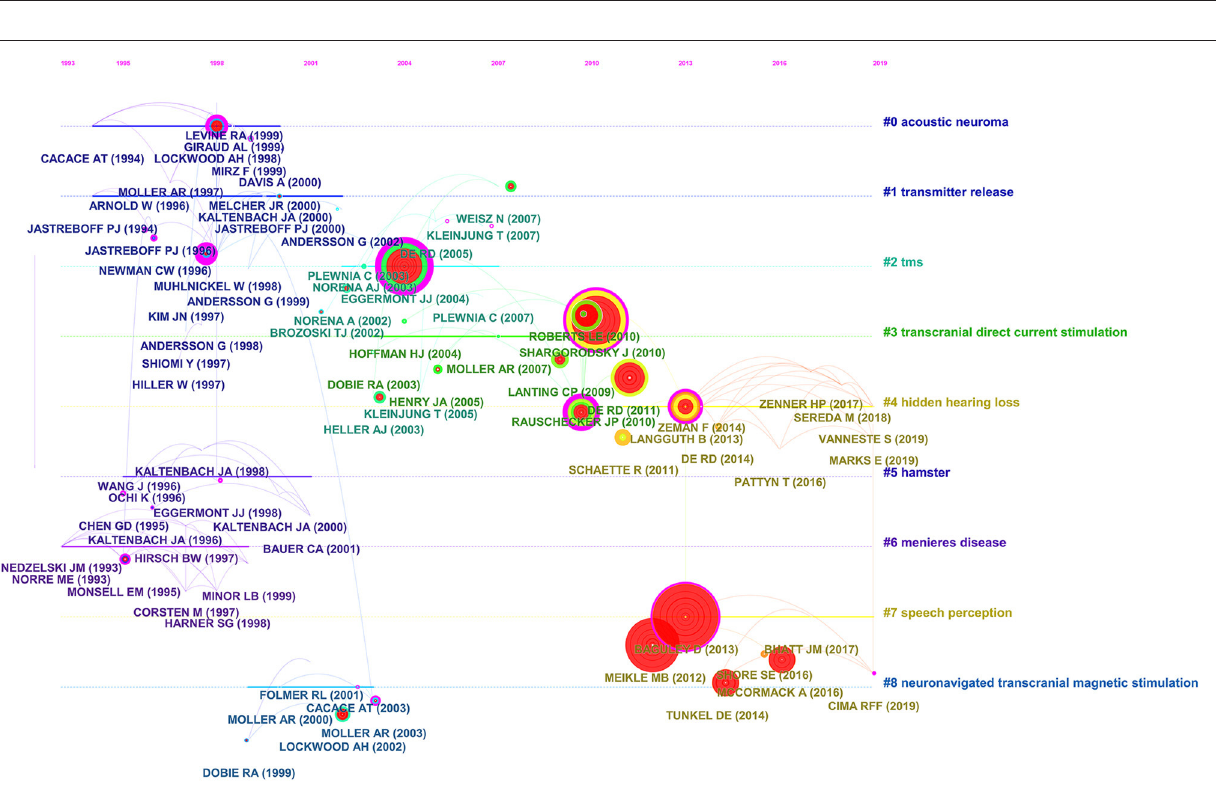
of diverse networks in individual patients. These